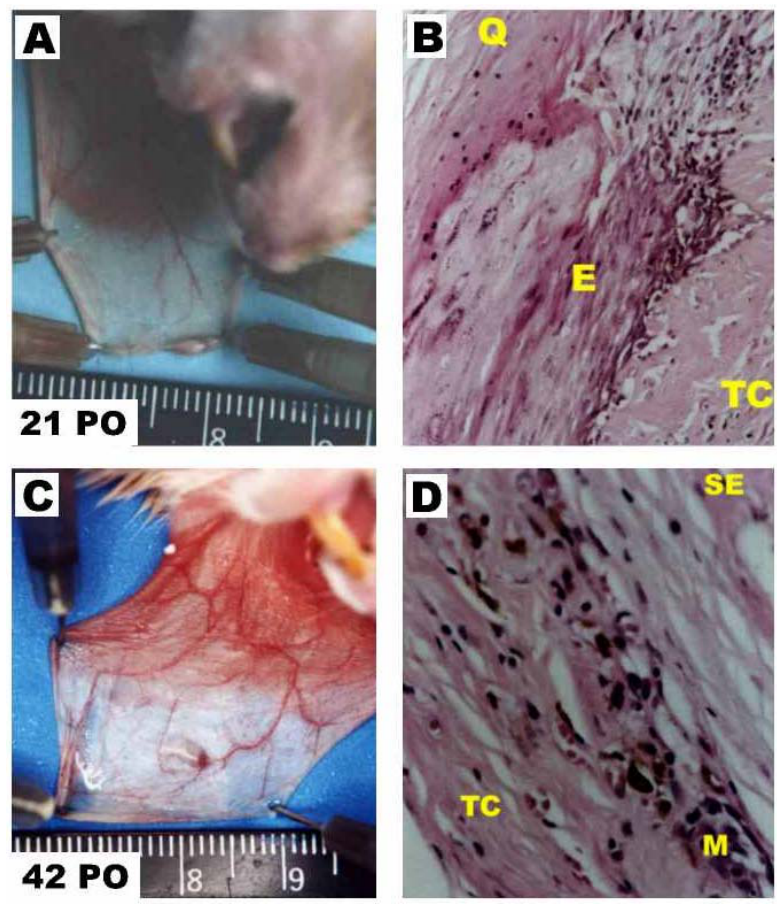
FIGURE 5 – Human skin graft at 21 days and keloid 42 days in the hamster cheek pouch